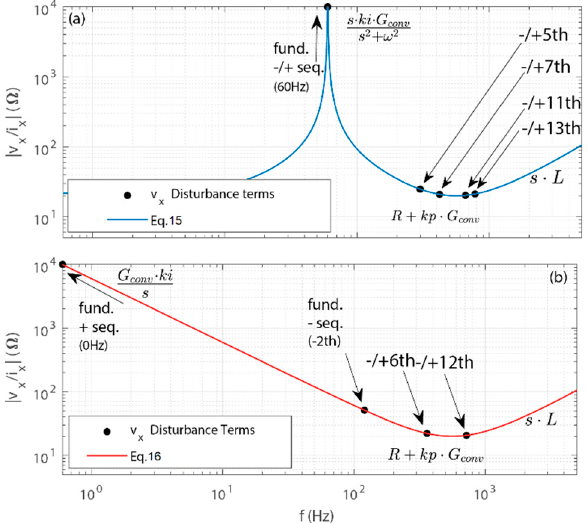
Figure 5. Dynamic stiffness analysis: ( a ) PR controller in abc and αβ frame, and ( b ) PI controller in dq frame.